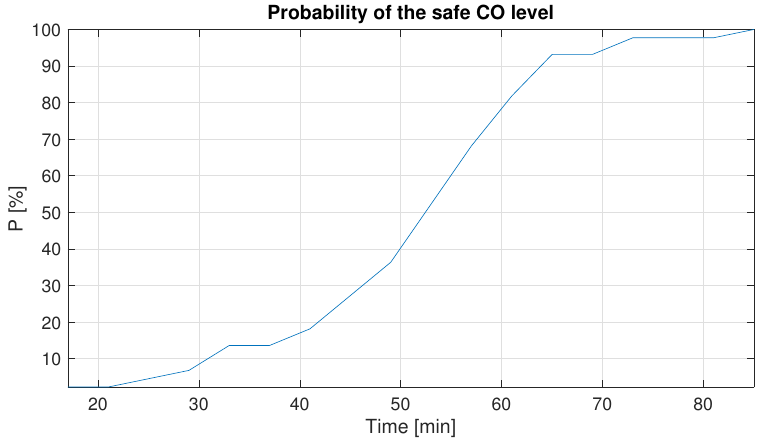
Figure 11. The empirical probability of the time needed to ensure the safe CO level after blasting procedure.